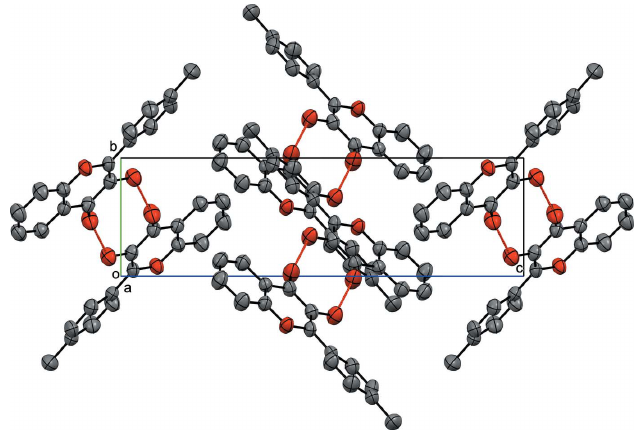
Figure 2 Crystal packing diagram of the title compound, viewed along the a axis. H atoms have been omitted for clarity and O (cid:2)(cid:2)(cid:2) O bonds represent hydrogen-bonded O-atom sites.